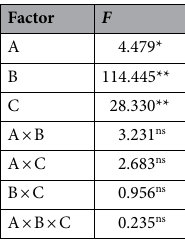
Table 1. Variance analysis of yield under different planting patterns and N level. A: Year; B: Planting pattern; C: N level. * P < 0.05; ** P < 0.01; ns: Not